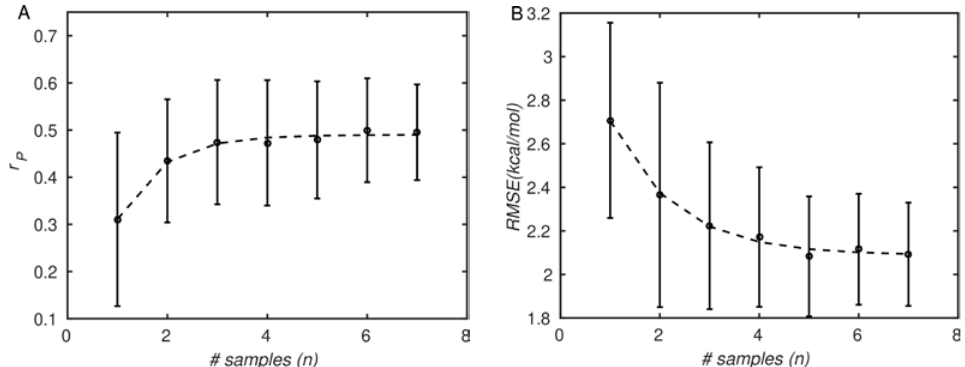
Figure 4. Agreement between PMF simulation results and experiments improves with the number of simulation repetitions. ( A ): Pearson correlation coefficient ( r P ); ( B ): root-mean-square error (RMSE). The symbols correspond to simulation and experimental data, and lines correspond to least-squares exponential fits. The error bars correspond to standard deviations, computed by bootstrapping (see Section 2. Materials and Methods).